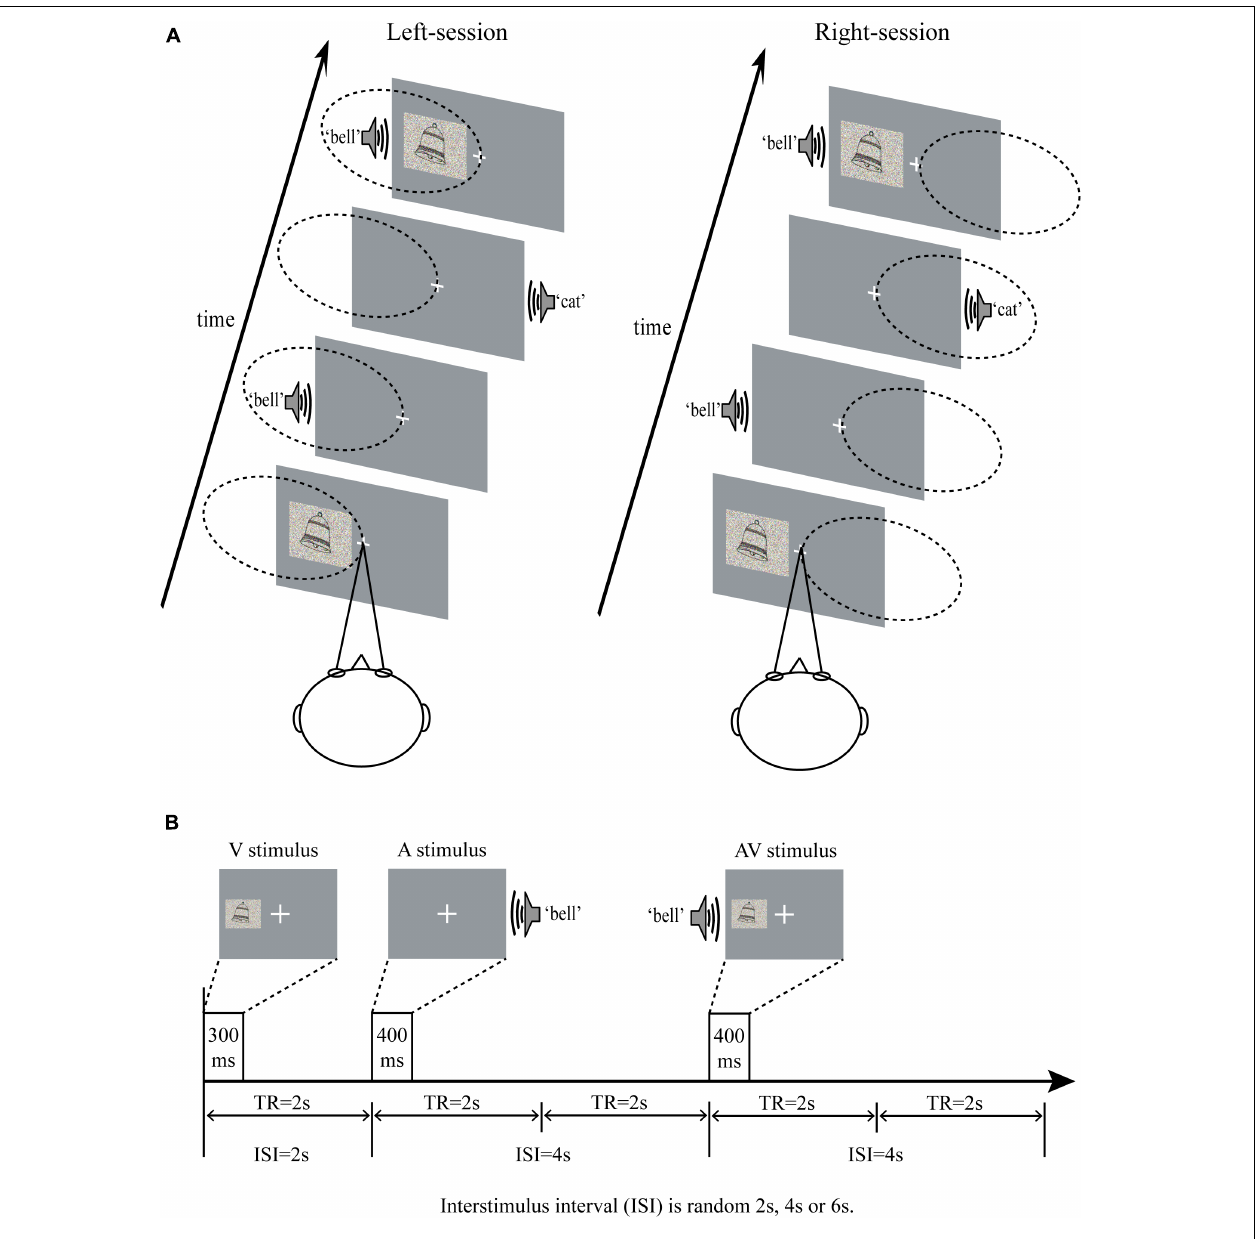
FIGURE 1 | (A) Schematic of the experimental design in left-sessions and right-sessions. The participants were instructed to look at the central fixation (a cross), and attended to the stimuli presented on the left side in left-sessions, and attended to the stimuli presented on the right side in right-sessions. The dotted ellipse indicated the position attended to. (B) Time course of the stimuli presentation. ISI, interstimulus interval; TR, repetition time; A, auditory; V, visual; AV, audiovisual.